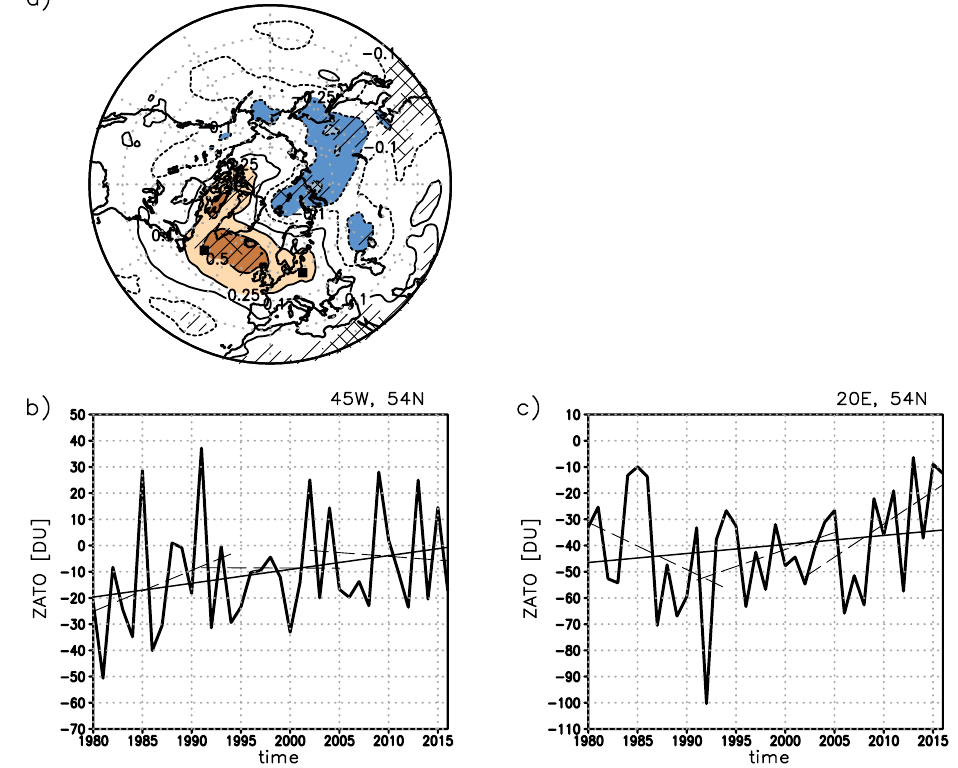
Figure 2. Linear regression coefficient (trend) for ( a ) ZATO for January (1980–2016) in [DU/year]. Crossed (single) hatched regions mark statistically significant trends on a 95% (90%) confidence level. Contour interval in ( a ) is in absolute values 0.1,0.25,0.5. Black filled squares in ( a ) marks two points. The time series of ZATO [DU] are plotted in ( b ) for 45 ◦ W, 54 ◦ N, and in ( c ) for 20 ◦ E, 54 ◦ N. The solid straight line indicates the linear regression over the whole period (climatological trend). Dashed lines in ( b , c ) indicate the secular trends for each